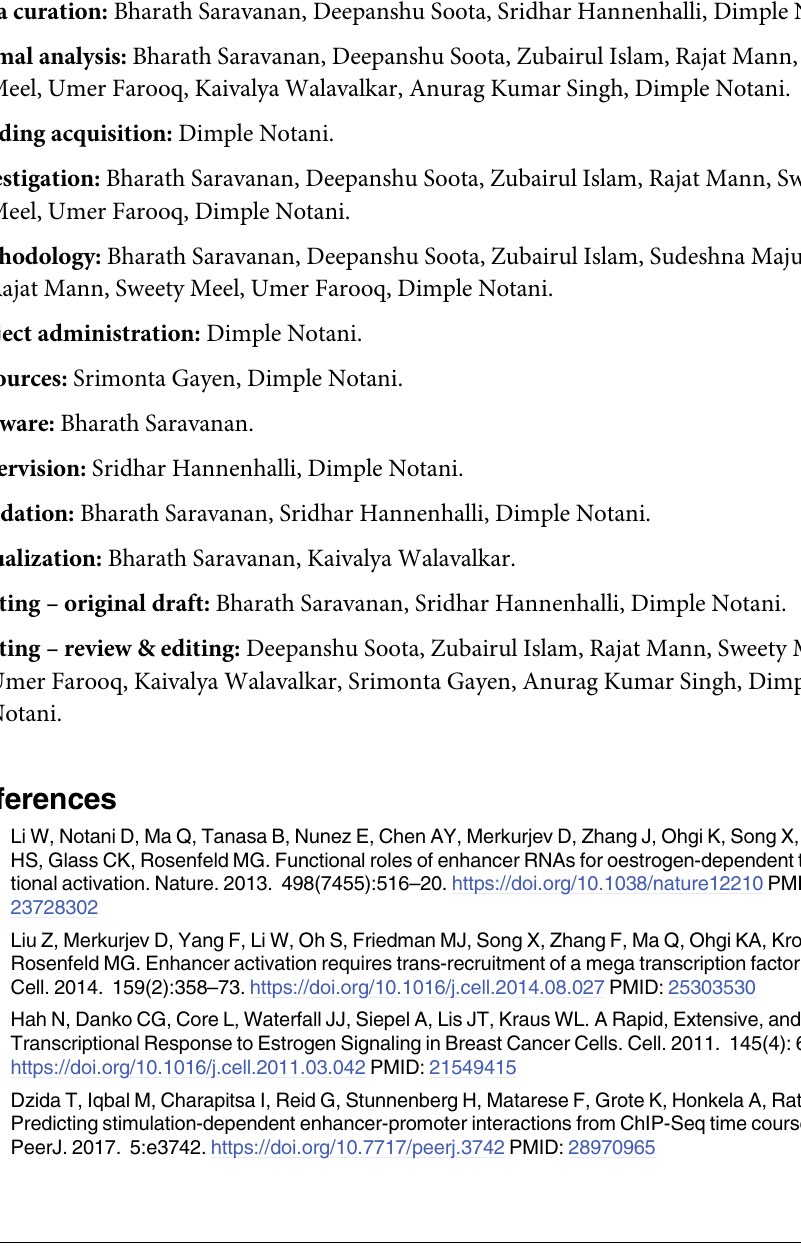
S5 Table. The table shows the called peaks for all ER α peaks, Persistent peaks, transient peaks, LEDC and TADs from processed NGS